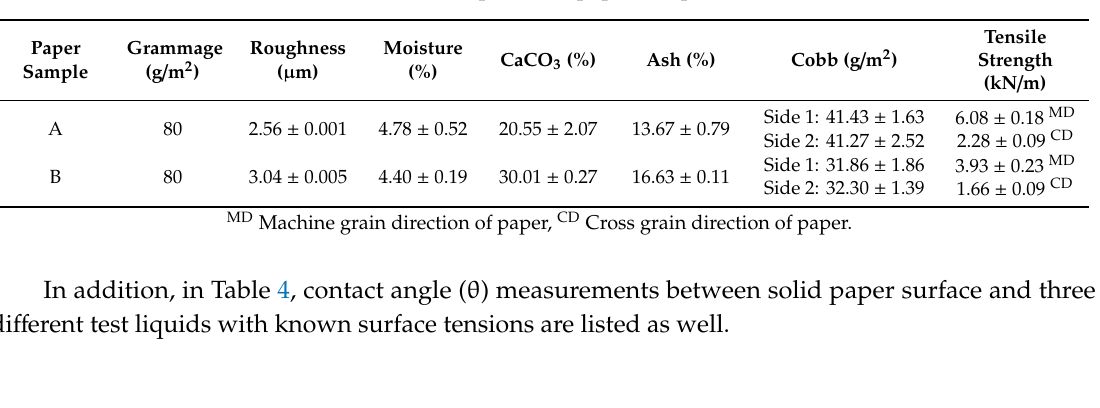
Table 3. Properties of paper